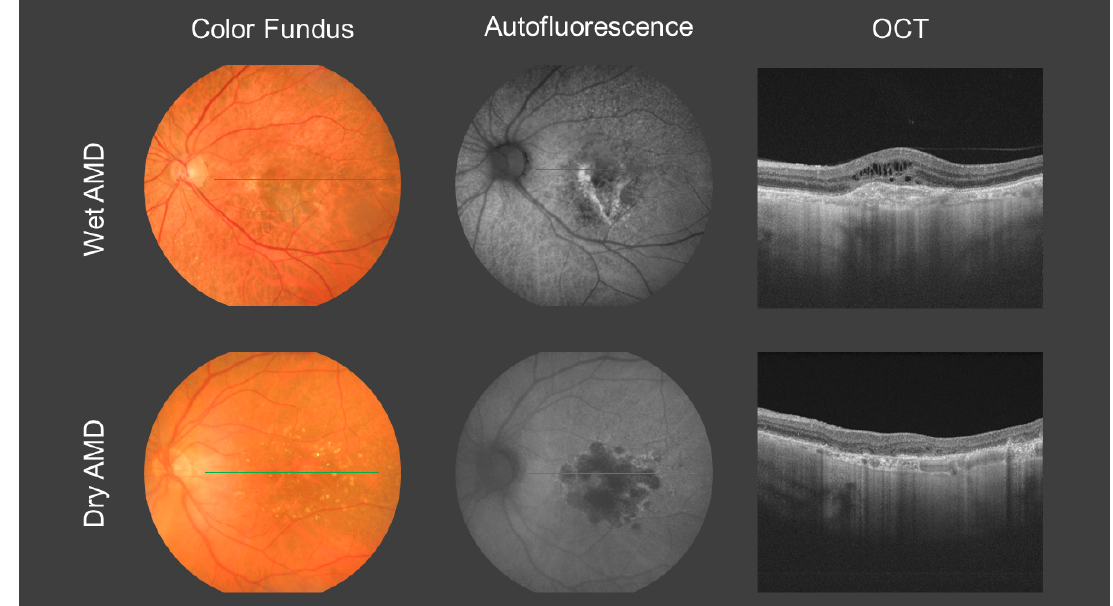
Figure 1. Representative retinographies and optical coherence tomography (OCT) of and eye with wet AMD and an eye with dry AMD. ( Top row ): Color fundus retinography, autofluorescence and OCT of the left eye of a patient presenting wet AMD. In retinography, choroidal neovascularization (CNV) can be seen as a grayish region covering the central macular area. Autofluorescece imaging shows a mixed pattern of hyperautofluorescence and hypoautofluorescence. On OCT the CNV can be clearly visualized as a hyperreflective layer under the retina with intraretinal fluid visualized as multiple hyporeflective spaces. ( Bottom row ): Color fundus retinography, autofluorescence, and OCT of the left eye of a patient presenting advanced dry AMD. In the retinography an area of central atrophy can be observed in the central macular area that allows better visualization of the choroidal vessels and is surrounded by multiple drusen. Autofluorescence clearly distinguishes the borders of the geographic atrophy due to hypoautofluorescence secondary to the retinal pigment epithelium (RPE) atrophy. OCT reveals atrophy of the RPE and outer retinal layers, with increased signal in the choroid and sclera. The green line represents the OCT section location.